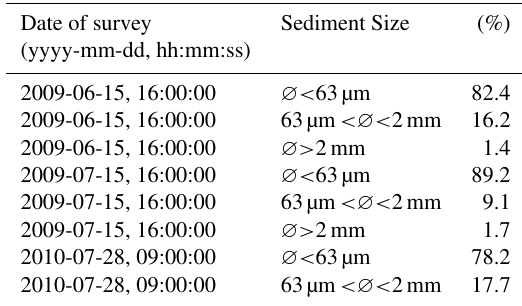
Table 2. Sediment size data inside the port (see the station identified using the red dot in Fig. 2). Three different surveys were carried out between June 2009 and July 2010. (All times are given in local